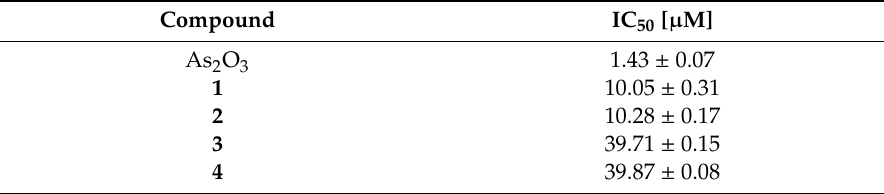
Table 5. Concentrations of di ff erent anti-cancer agents that inhibit 50% of NB4 cell growth, after 48 h of